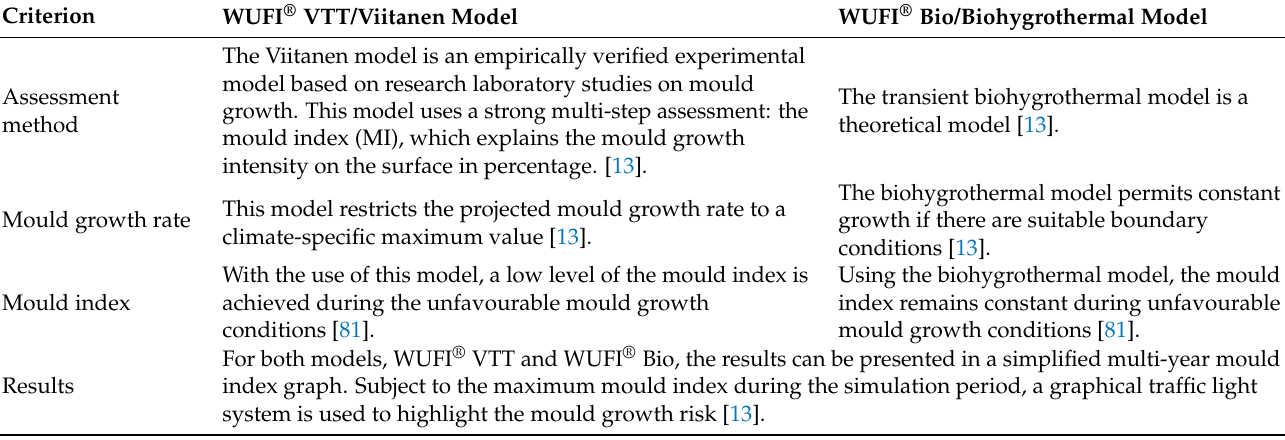
Table 1. Comparison between the WUFI ® VTT model and WUFI ® Bio